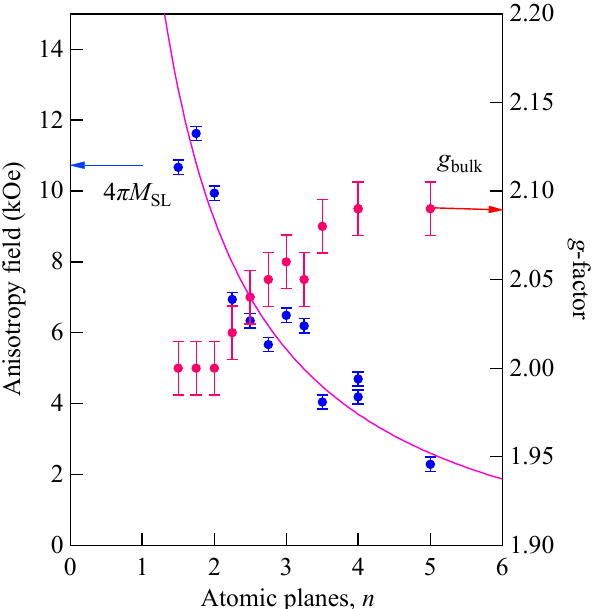
Figure 30. g ‑factor ( • ) and anisotropy field ( • ) as a function of n . The solid line shows the perpendicular anisotropy field H A ( n ) = 22/ n − 1.8 (kOe). The solid line represents the 1/ n dependence given by H A ( n ) = 22/ n − 1.8 (kOe). The